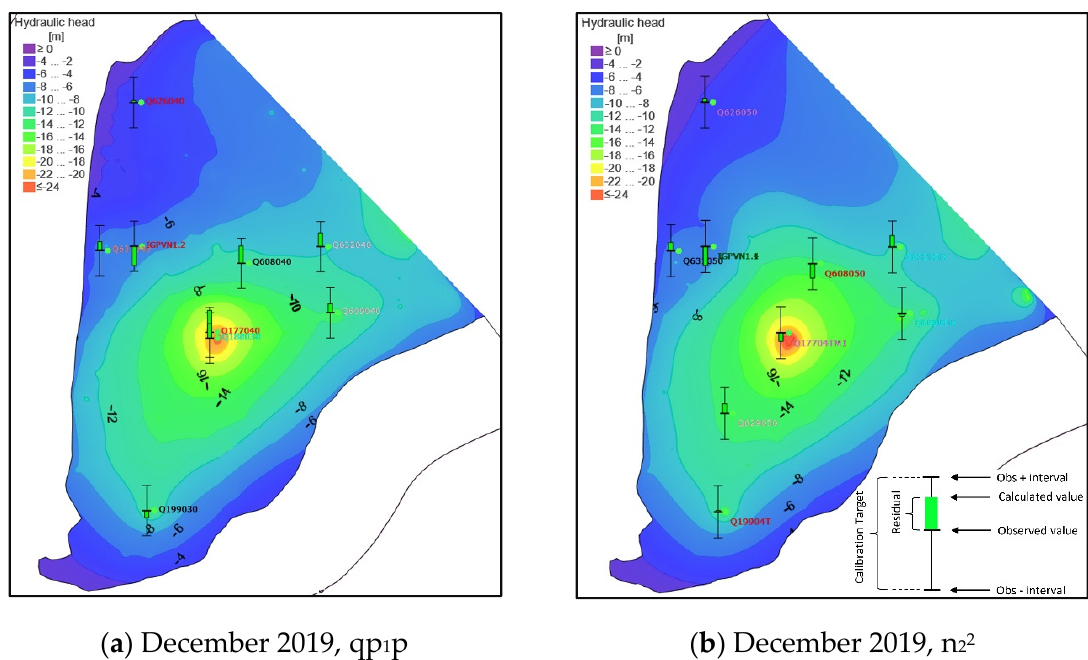
Figure 9. Hydraulic head for aquifers qp 1 and n 22 in December 2019.